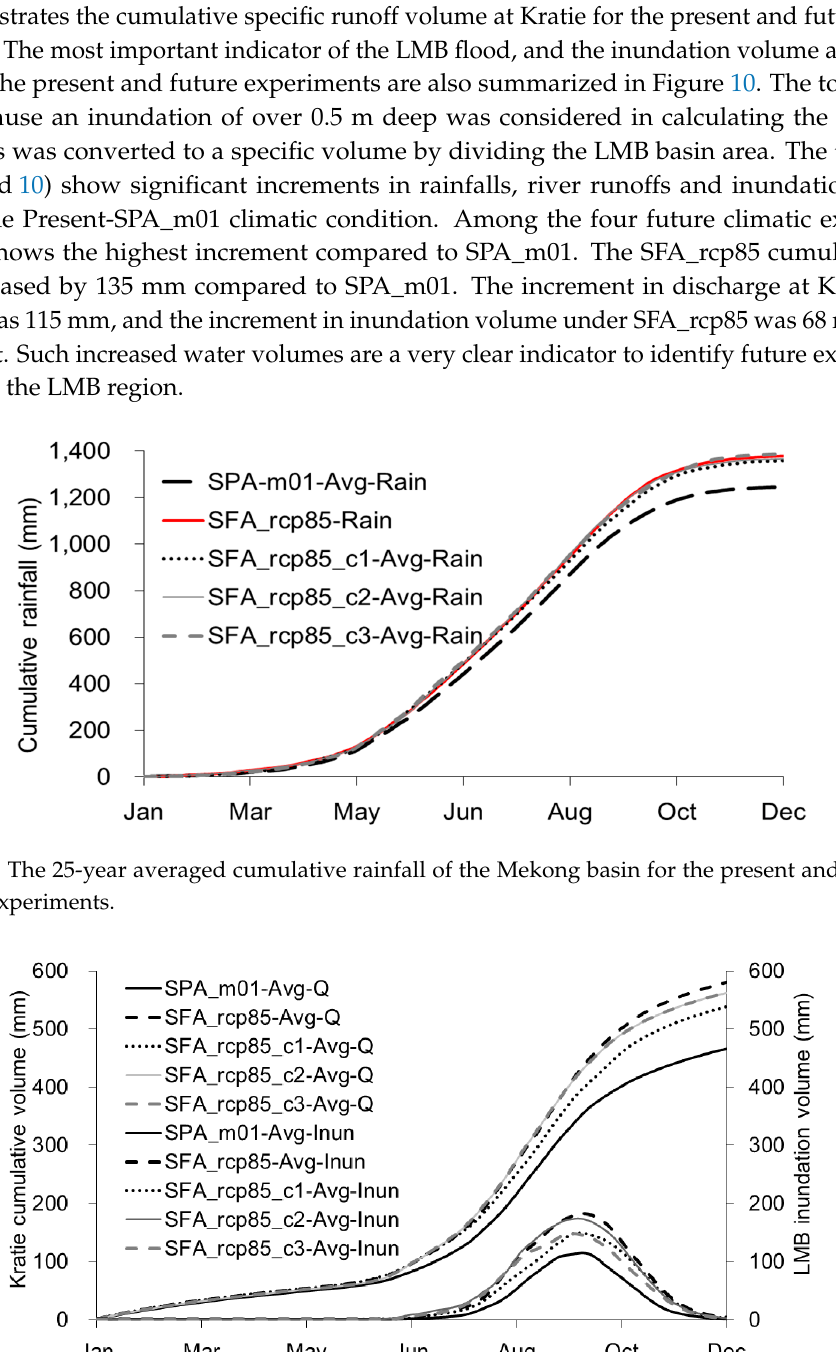
Figure 10. The 25-year averaged cumulative specific river runoff volume at the Kratie station and 25-year averaged cumulative specific inundation volume (above 0.5 m) in the LMB.